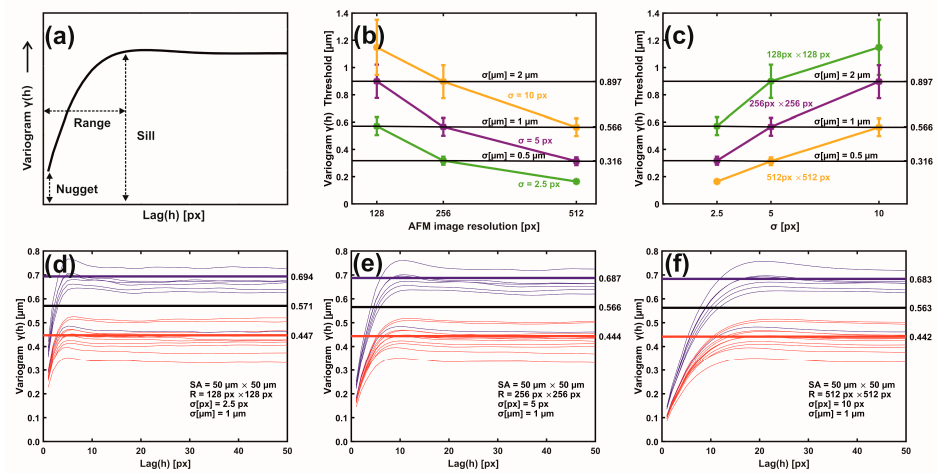
Figure 4. Metastatic/non-metastatic 1D variograms of residual Gaussian filtering. ( a ) A variogram’s typical parameters. ( b ) Metastatic threshold vs. AFM image resolution for different σ (px, µ m) values. The metastatic threshold stays invariant for identical σ ( μ m) values. ( c ) Metastatic threshold vs. σ (px) at different AFM image resolutions. The metastatic threshold is invariant for identical σ ( μ m) values. ( d ) Variogram lines of metastatic (red) and non-metastatic (blue) groups. AFM image size 50 μ m × 50 μ m, resolution 128 px × 128 px, standard deviation σ ( μ m) = 1 μ m, σ (px) = 2.5 px. The black sill line is the metastatic threshold defined as the median value of mean sill values of metastatic and non-metastatic tissues. Above the threshold line, tissues are non-metastatic, and they are metastatic below the line. Red and blue lines represent the mean metastatic/non metastatic sill values. ( e ) The same as ( d ) with image resolution 256 px × 256 px and σ (px) = 5.0 px. ( f ) The same as ( e ) with image resolution 512 px × 512 px, and σ (px) = 10.0 px.